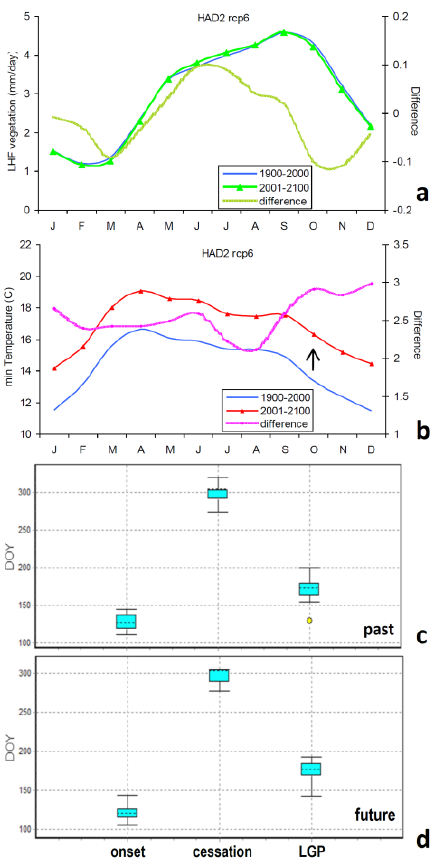
Figure 7. Hadley2-rcp6 annual cycle in past, future, and difference: ( a ) LHF vegetation, and ( b ) minimum T, the arrow points to warming in October. Box and whisker plot of onset, cessation, and LGP of ( c ) past and ( d ) future era: (dashed: median, box: 25/75 th percentile, whisker: 10/90 th percentile, o: extreme value).